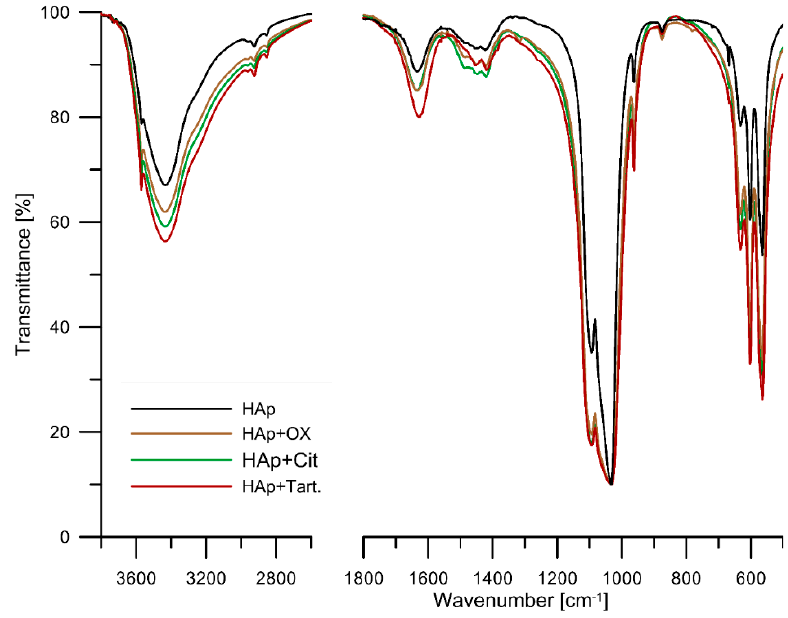
Figure 6. FTIR transmittance spectrum of hydroxyapatite (HAp), hydroxyapatite with adsorbed oxalic ions (HAp + OX), hydroxyapatite with adsorbed citrate ions (HAp + Cit), hydroxyapatite with